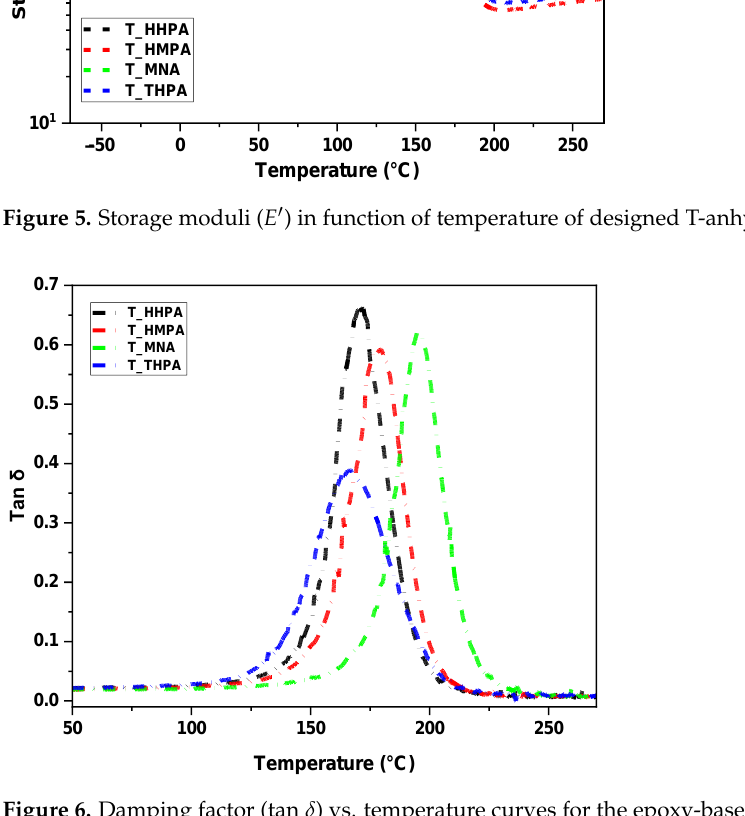
Figure 6. Damping factor (tan δ ) vs. temperature curves for the epoxy-based thermoset resins. The surface hardness of the materials was also tested and analyzed by Shore hard- ness tests. The obtained result ranged between 84 and 90 Shore D being superior to previ- ously developed materials (TGPH systems = 87 – 89 SD, DGEVA-systems = 80 – 81 SD) [11]. The developed thermosets can be classified as extra hard materials being similar to com- mercial ones: Kohesi Bond KB 1427 HT-3 = 85 SD; Henkel Loctite ® Stycast ® EO 1058 = 90 SD, etc.